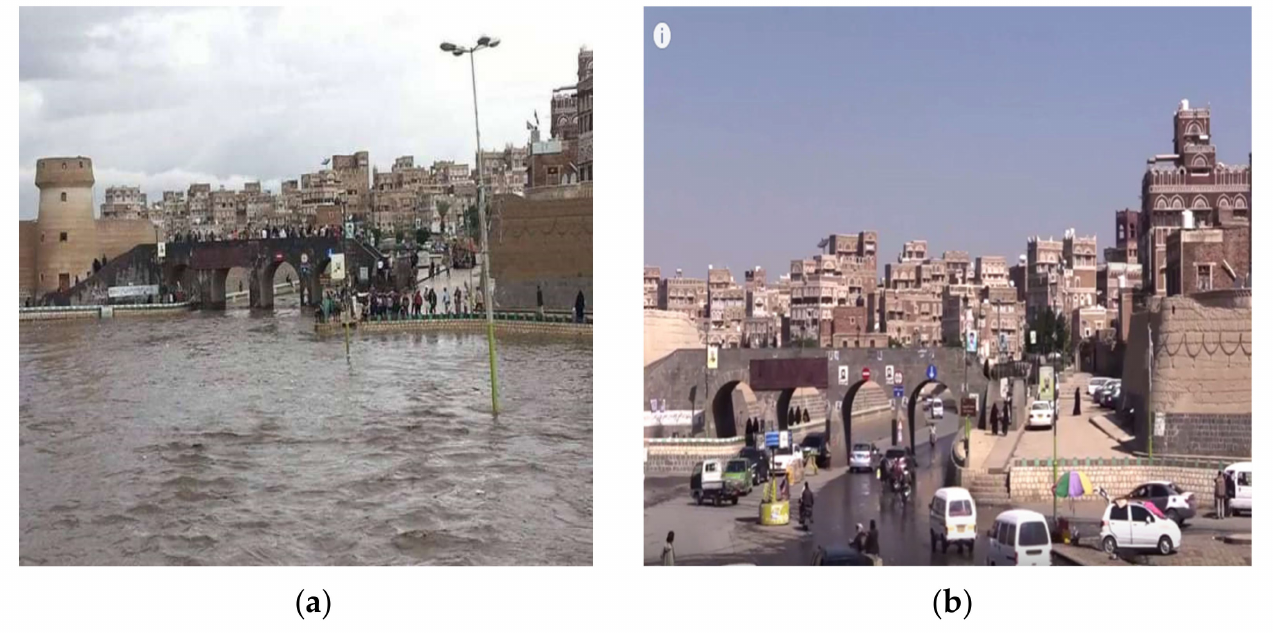
Figure 4. Flood effect on Sana’a city in Alsailah channel: ( a ) Sana’a city with flood; ( b ) Sana’a city without